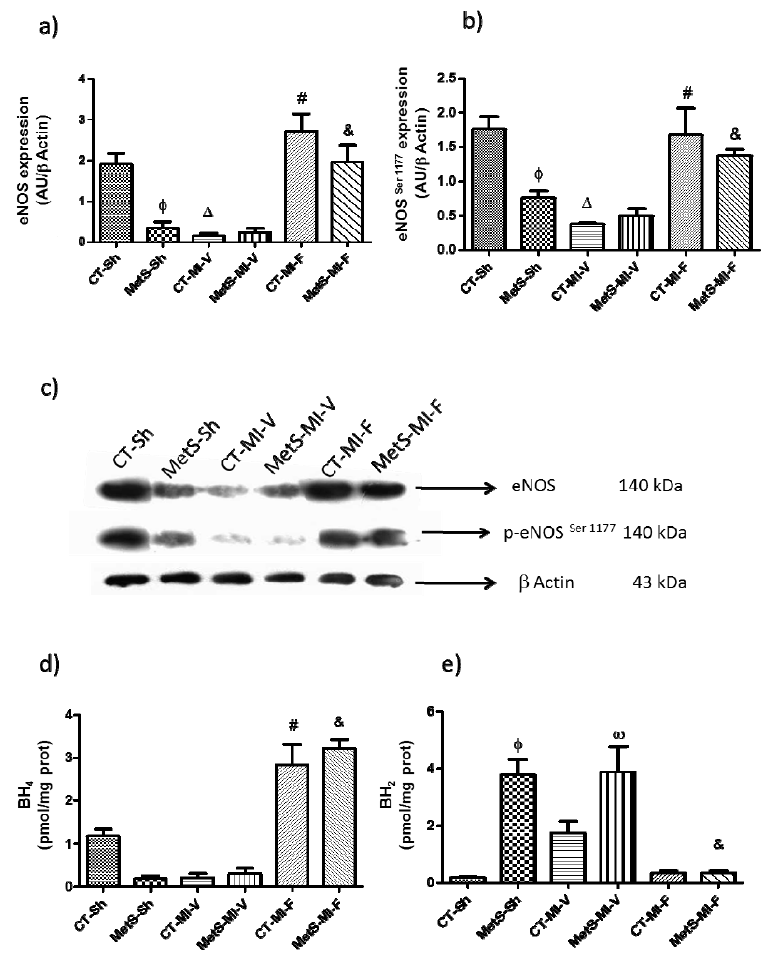
Figure 6. Effect of fenofibrate on myocardial expression of eNOS and biopterin concentrations. ( a ) Expression of eNOS; ( b ) Expression of p-eNOS Ser1177 ; ( c ) Representative western blot; ( d ) Biopterin levels; ( e ) Oxidized form of biopterin. Protein expression and biopterin concentrations were evaluated in the left ventricles from control (CT) and metabolic syndrome (MetS) rats subjected to sham- (Sh-) or myocardial infarction and treated two weeks with either vehicle (V) or fenofibrate (F). Data represent mean ± SEM ( n = 5 per group). φ p < 0.05 vs. CT-Sh; Δ p < 0.05 vs. CT-Sh; # p < 0.05 vs. CT-MI-V; & p < 0.05 vs. MetS-MI-V; ω p < 0.05 vs. CT-MI-V. Analysis of variance-Tukey.